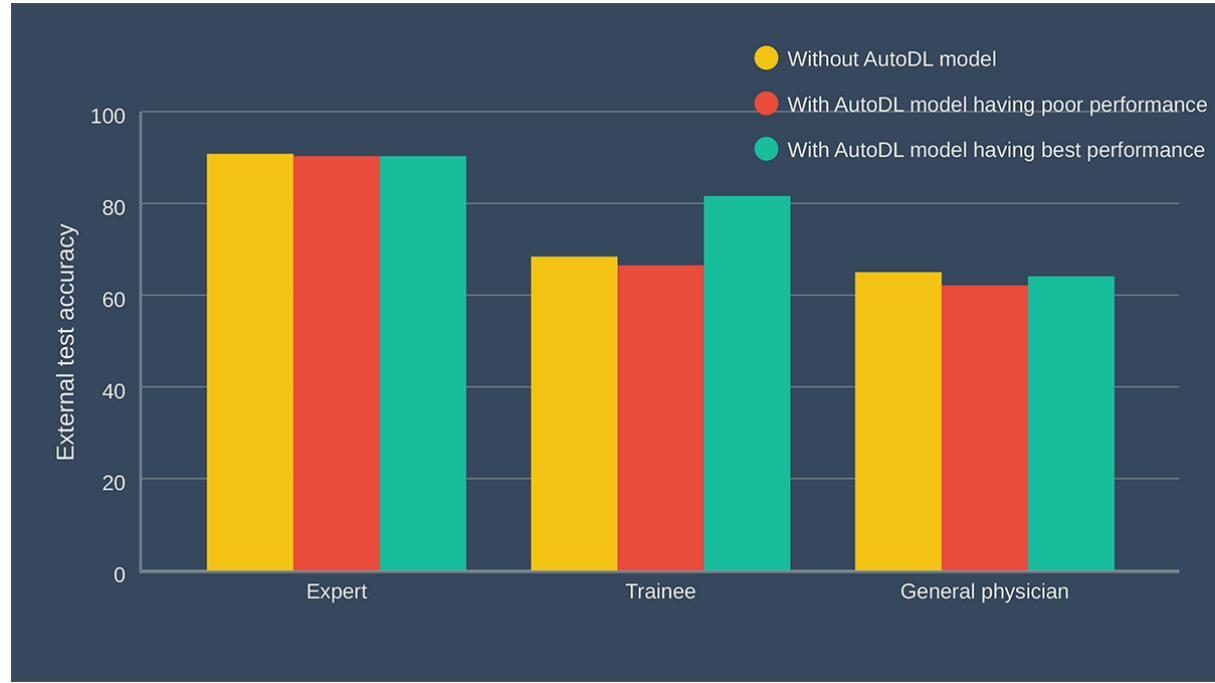
Figure 4. Endoscopist–artificial intelligence interactions. AutoDL: automated deep